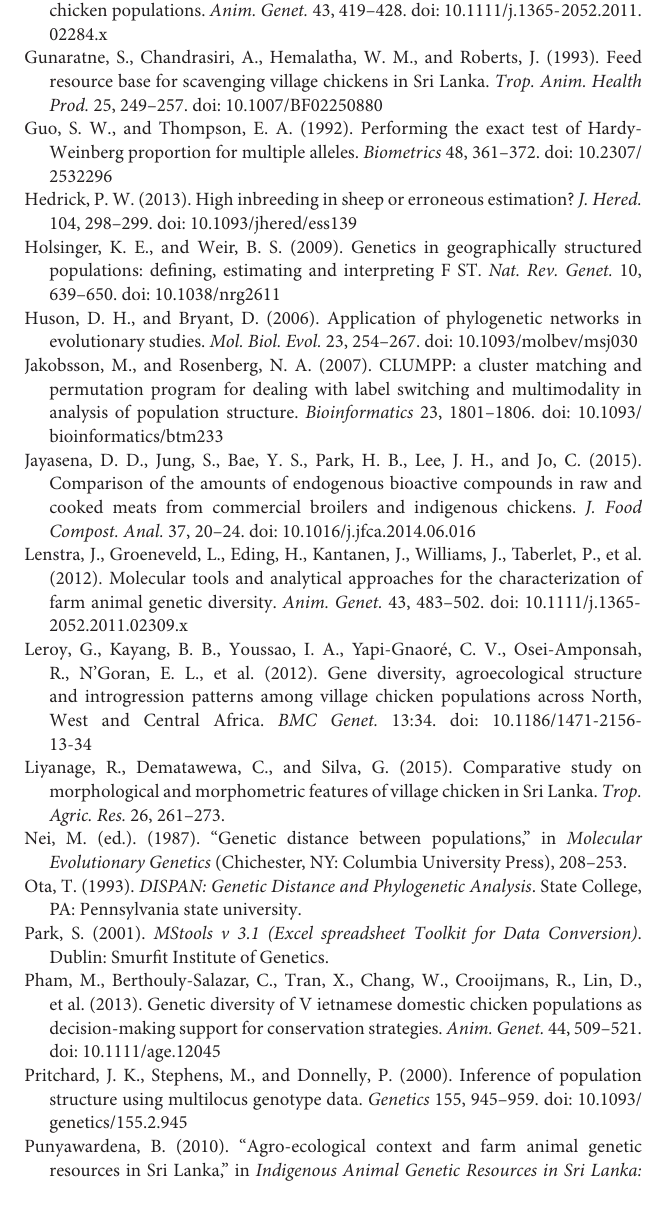
Supplementary Table 2 | Allele sizes of 20 microsatellite markers for five village populations: Dematagama (DM), Labunoruwa (LA), Ooththupitiya (OT), Tabbowa (TB) and Thewanuwara